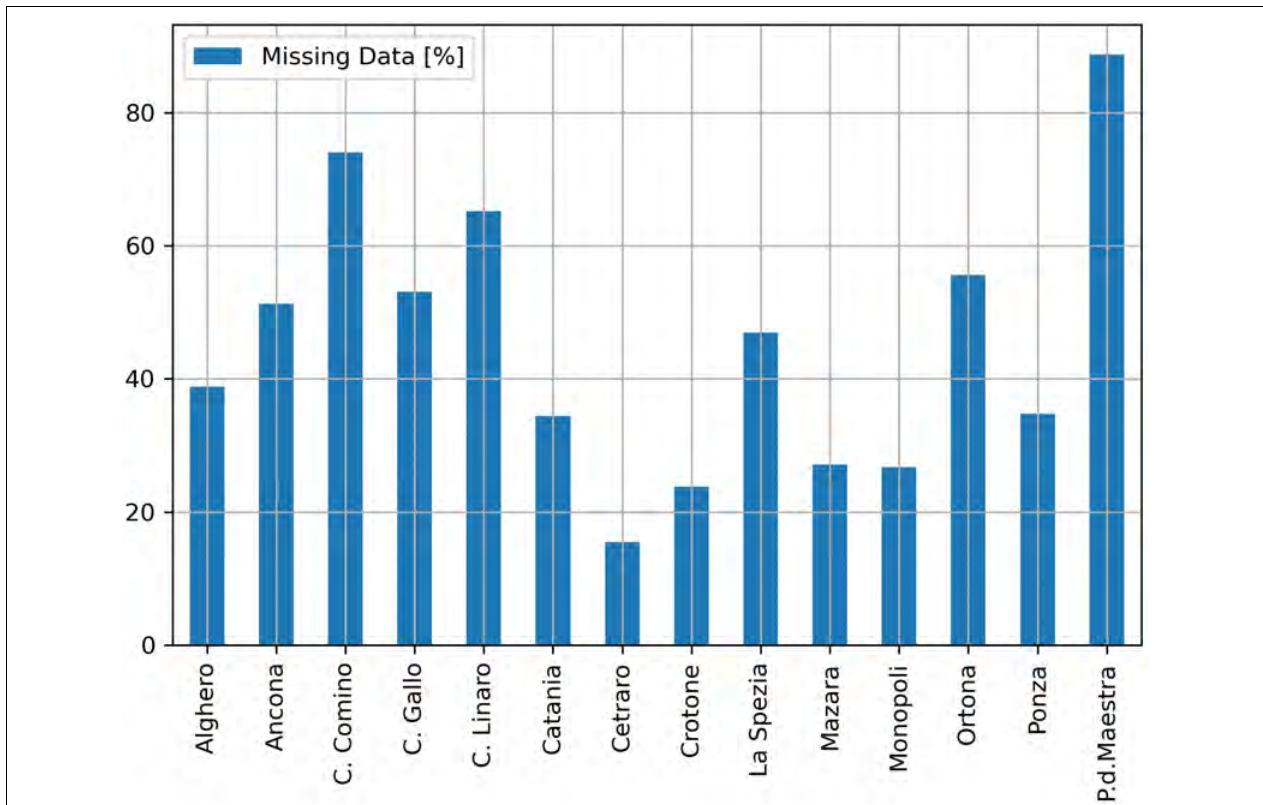
FIGURE 1 | Missing data percentage of the 14 buoys of the Italian Data Buoy Network from 2002 to 2006. Source (Picone,